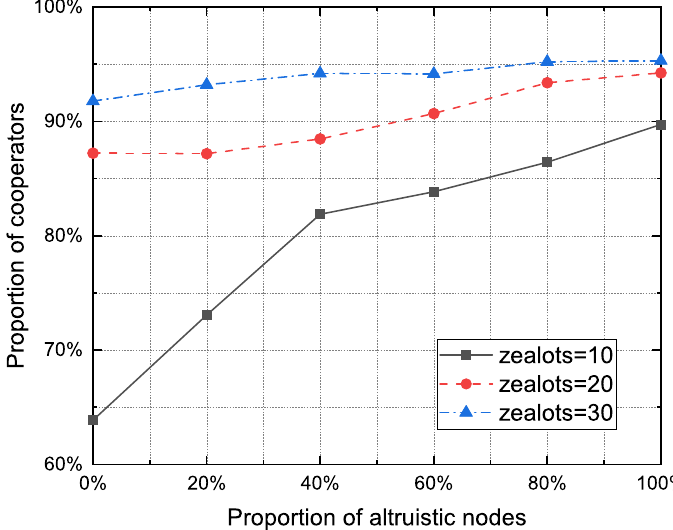
Figure 12. The proportion of cooperators to the zealot numbers for different altruistic node